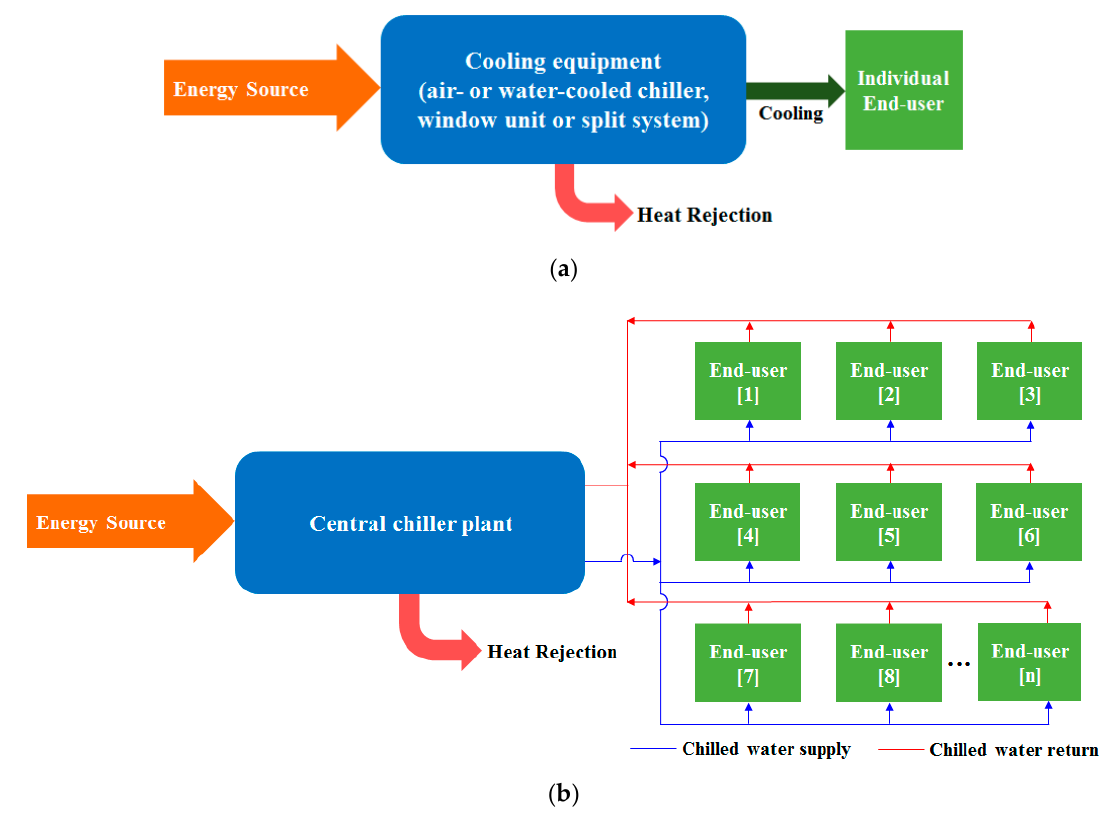
Figure 1. Building air-conditioning systems: ( a ) conventional on-site systems, ( b ) DC systems.